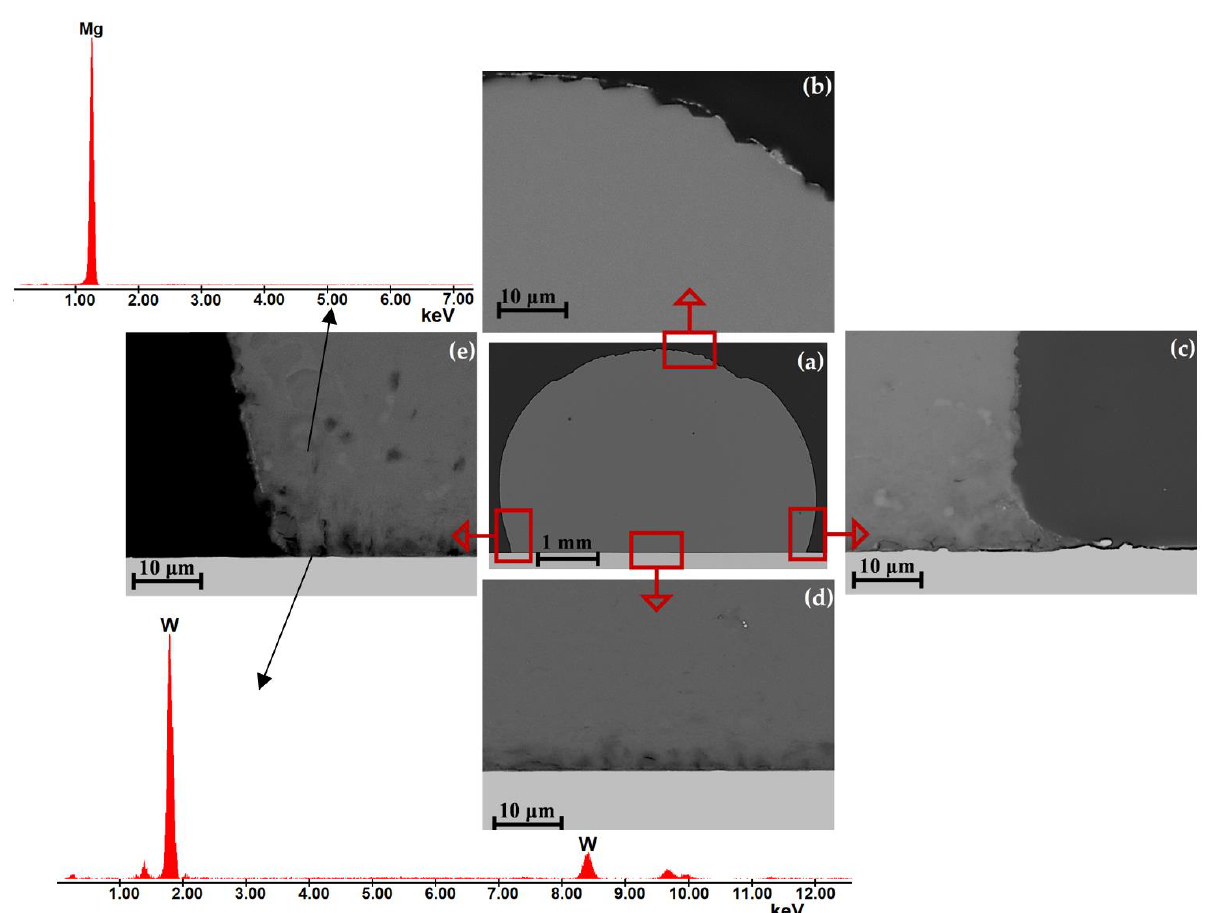
Figure 8. SEM images of a cross-sectioned Mg/W couple (CP: 740 °C, 180 s, Ar) taken with a BSE detector at ( a ) magnification 50 × and ( b – e ) magnification 5000 × ; ( b ) top of the drop, ( c ) right drop edge, ( d ) drop/substrate interface, and ( e ) left drop edge with EDS spectra of spot analysis.